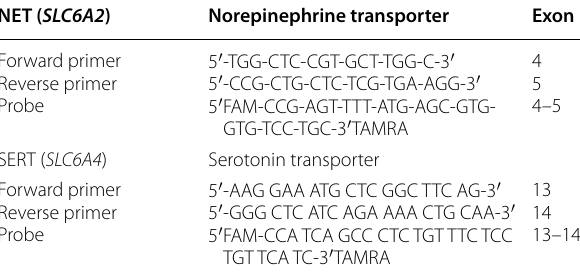
Table 1 Primer and probe combinations NET ( SLC6A2 ) Norepinephrine